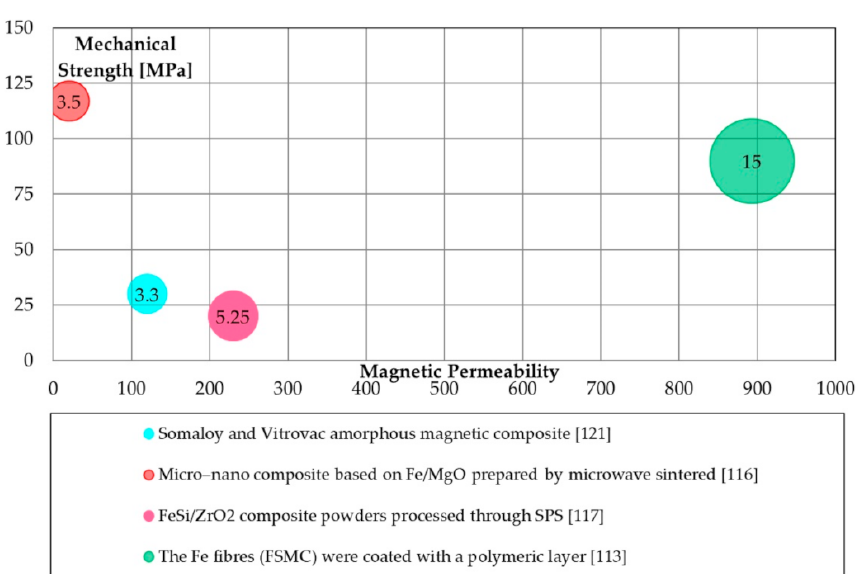
Figure 6. Magnetic (maximum permeability), mechanical (TRS [MPa]), and energetic properties (total iron losses 1 T@50 Hz [W/kg]) of other inorganic coating processes.